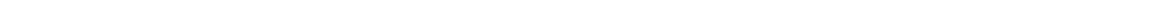
Fig. 1 Integrative functional screens identify cellular miRNAs modulating HCV infection. a Schematic of the primary screen. b – e Volcano plots showing Z scores and P values ( − log 2 scale, Student ’ s t test) from miRNA mimics in part one ( b ) and part two ( c ), and inhibitors in part one ( d ) and part two ( e ) of the HCVcc screen. Representative images and quantitative analyses of HCV core staining in cells transfected with select miRNA mimics or inhibitors, as indicated, are shown beside the volcano plots. Green, HCV core; blue, cell nuclei. Scale bars, 100 μ m. Numbers represent the percentages of core staining- positive cells (the mean ± SD, n = 3). Ctrl, miRNA mimic or inhibitor negative control. f Heatmap eliciting Z scores for primary screen hits with opposite mimic and inhibitor phenotypes. Z scores in the heatmap are depicted in a continuum from blue (reduced infection — antiviral) to red (enhanced infection —